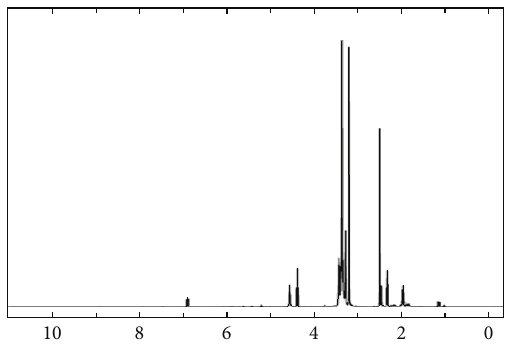
Figure 2: 1 H-NMR of TMEVS/NVP copolymer.